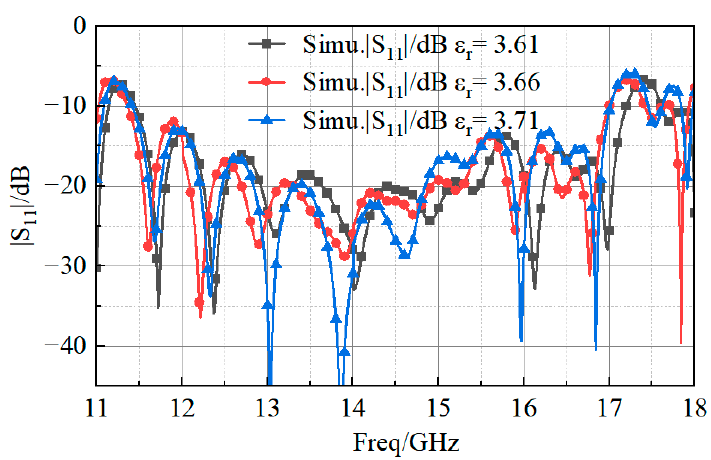
Figure 19. Simulated re fl ection coe ffi cient magnitude values. Table 3. Simulation of antenna bandwidth at high and low temperatures.